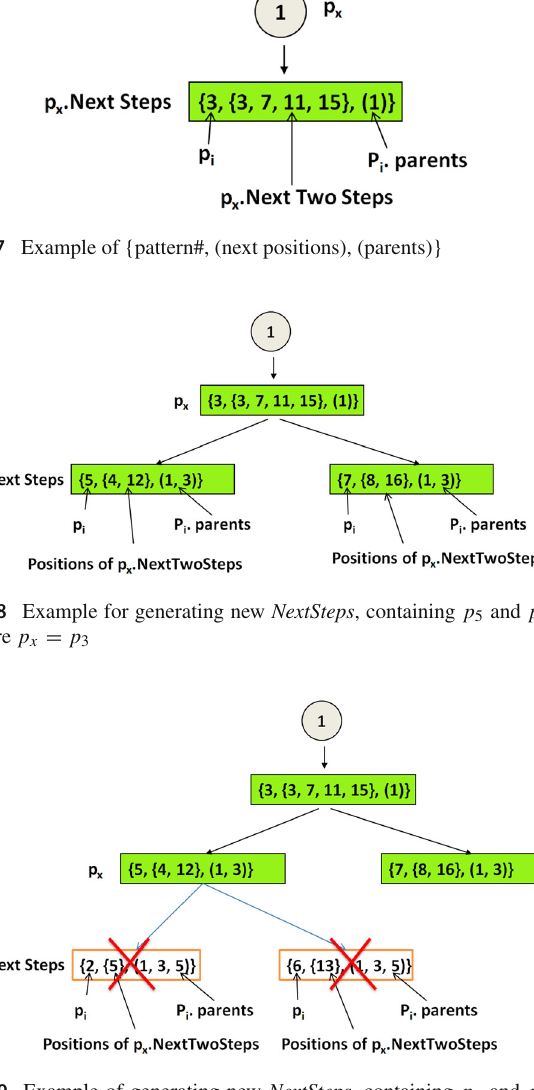
Fig. 9 Example of generating new NextSteps , containing p 2 and p 6 , where p x = p 5